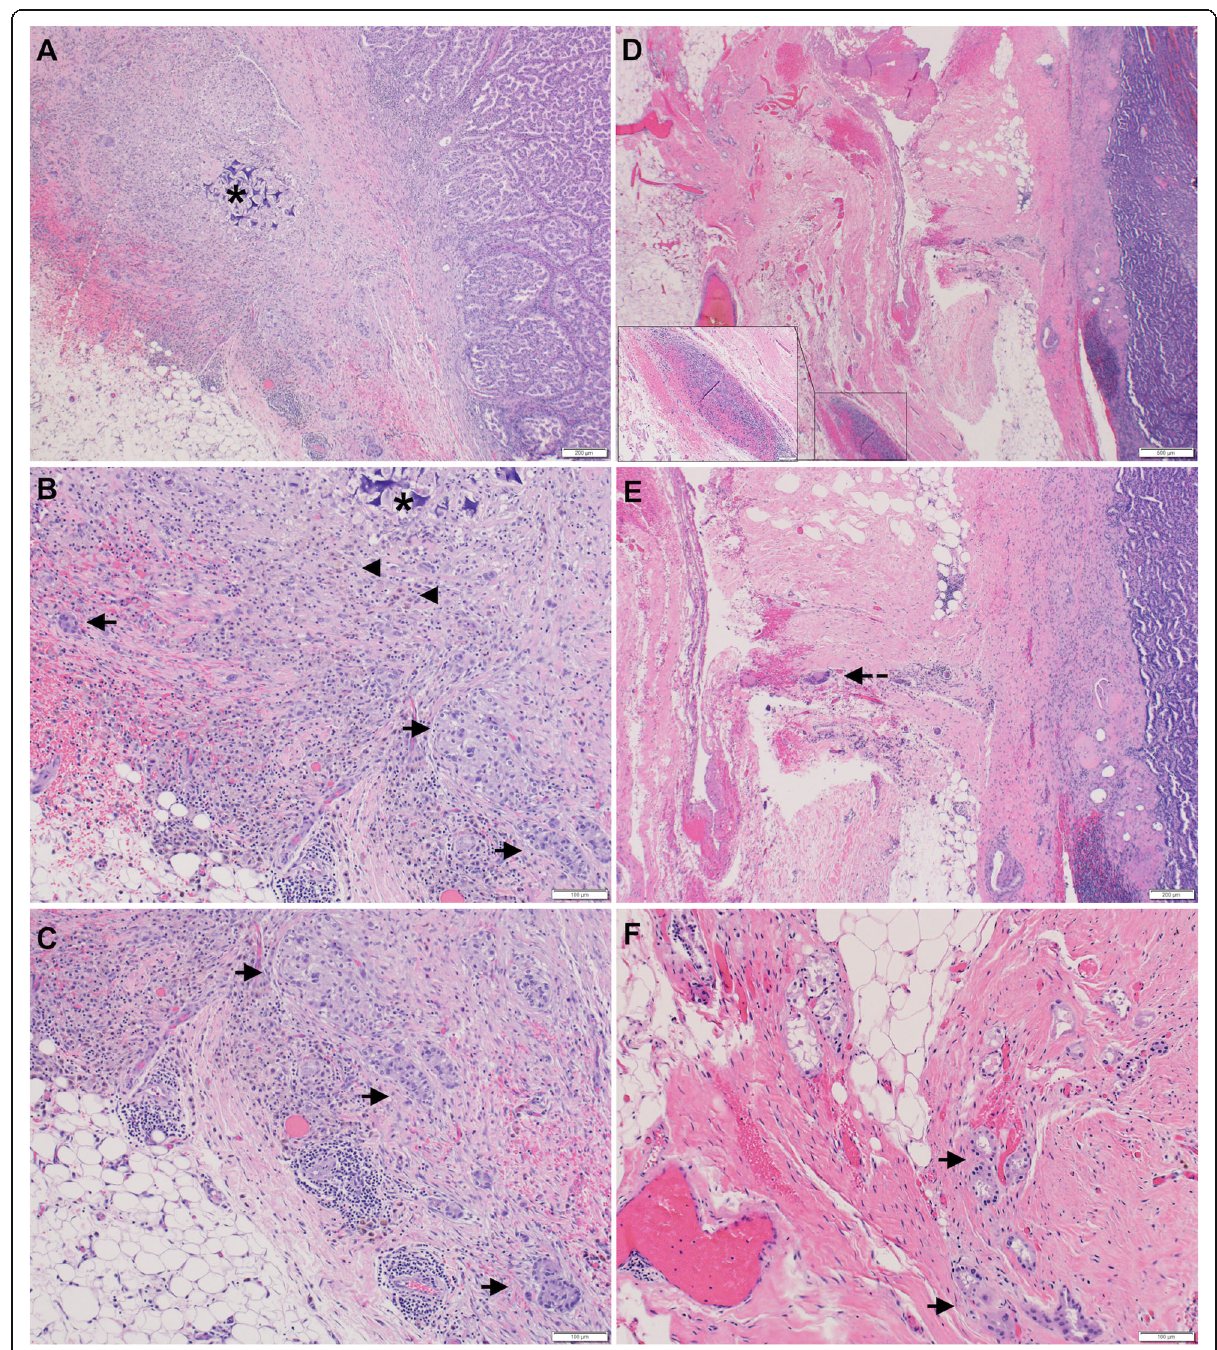
Fig. 1 Representative images of two cases ( a - c and d - f , respectively) demonstrating the histologic evidence of biopsy site changes and tumor seeding along the biopsy site. ( a ) Low power view showing the primary PRCC, perinephric tissue with biopsy site changes and tumor seeding to the adjacent perinephric adipose tissue beyond the renal capsule; ( b ) biopsy site changes showing combination of foreign material deposition (asterisk = gelfoam), foreign body reaction, hemosiderin deposition (arrowhead) and fibrosis, as well as a few clusters of tumor cells (arrow) seeded within the biopsy site; ( c ) High power view highlighting nests of tumor cells (arrow) seeded in the perinephric adipose tissue; ( d ) Low power view showing the primary PRCC confined within the capsule and perinephric tissue with biopsy site changes with hemorrhage and foreign material deposition (inset); ( e ) perinephric tissue with foreign body reaction (dashed arrow); ( f ) High power view highlighting nests of tumor cells (arrow) seeded in the perinephric adipose